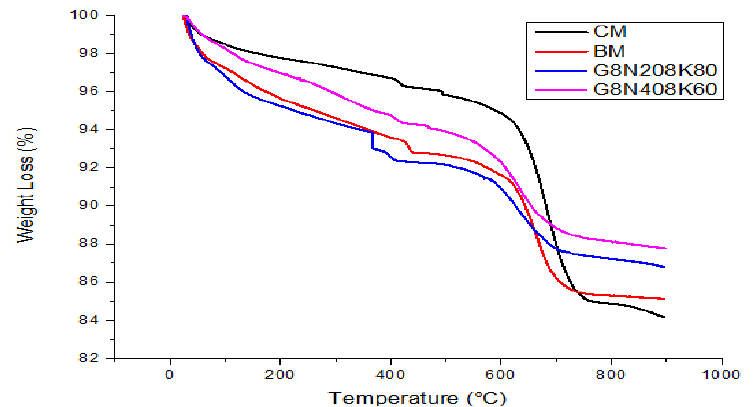
Figure 13. TGA of geopolymer concrete and control mixtures.